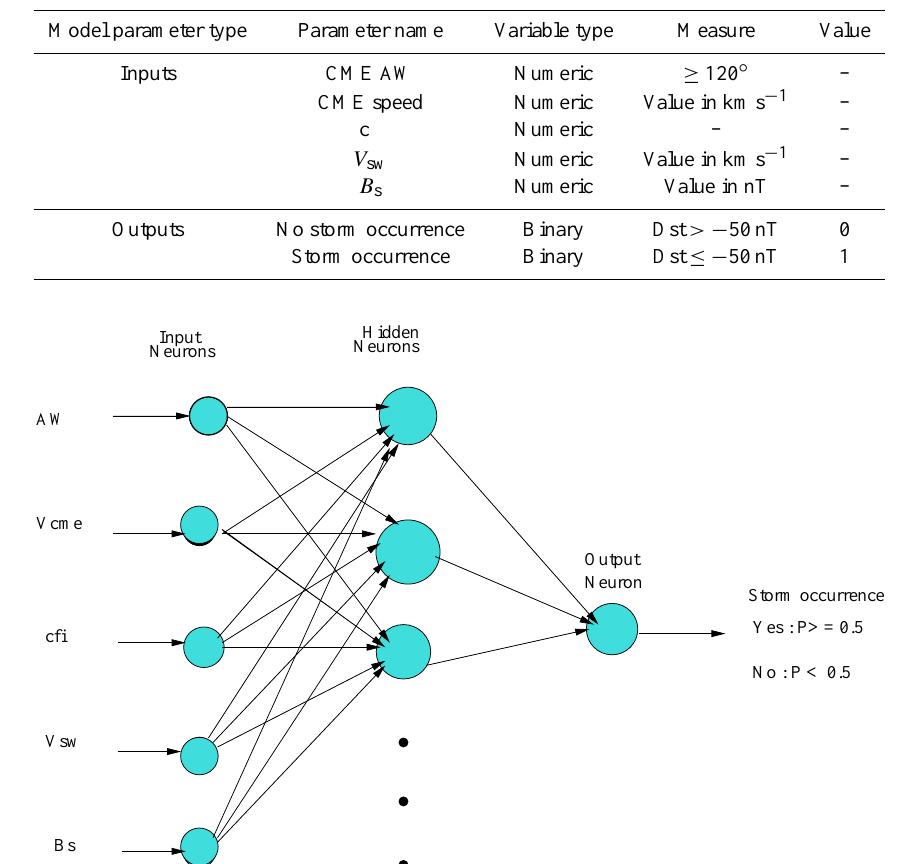
Table 1. Characteristics of the NN input and output parameters.